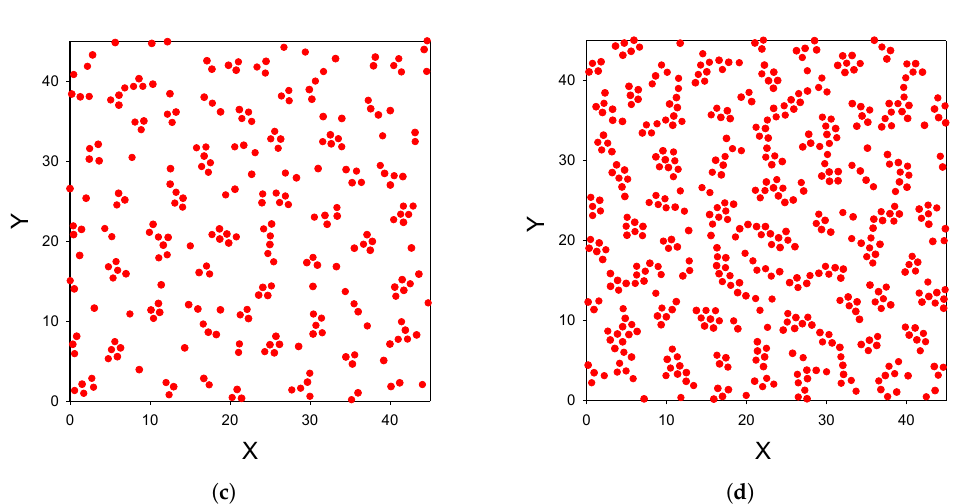
Figure 1. Distribution of the particles near an attractive surface in the one-component system with particle–particle and wall–particle interactions given by (1) and (3), respectively, for ¯ T = 0.25 and ρ 1 = 0.0023 (volume fraction π ρ 1 = 0.0012). Dimensionless density ρ 1 ( z ) as a function of a distance 6 z from the surface is shown for γ attr = 4 and γ attr = 6 in panels ( a , b ), respectively. Projection on the ( x , y ) plane of particles (red circles) belonging to a layer of molecular thickness parallel to this plane, 0 < z < 1.6, is shown for γ attr = 4 and γ attr = 6 in panels ( c , d ), respectively, for representative configurations (snapshots). X , Y and z are in units of the diameter of the particles a . Simulations were performed for the initial number of particles N 0 =